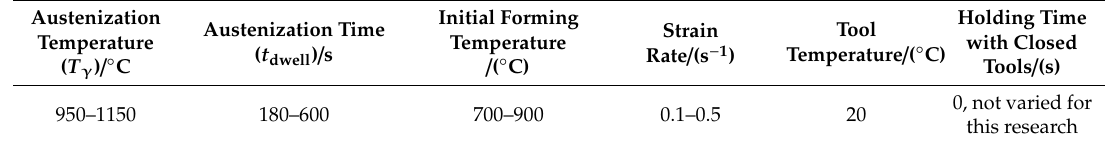
Table 3. Thermomechanical process parameters of interest for this